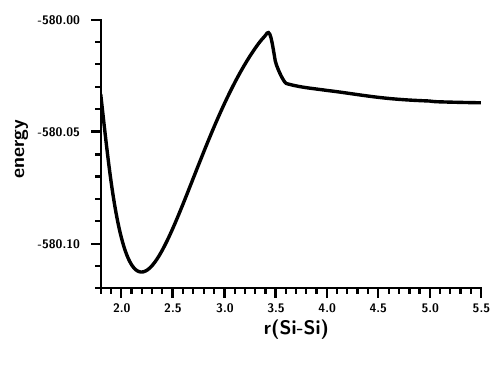
Figure 6. Planar silylene dimerization. The energy curve for the Si–Si bond stretching. Energy in Hartrees; bond length in Å.